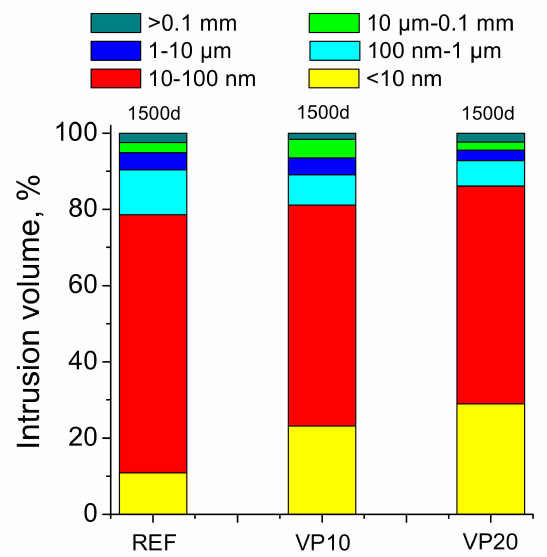
Figure 4. Pore size distributions noted for the series studied.